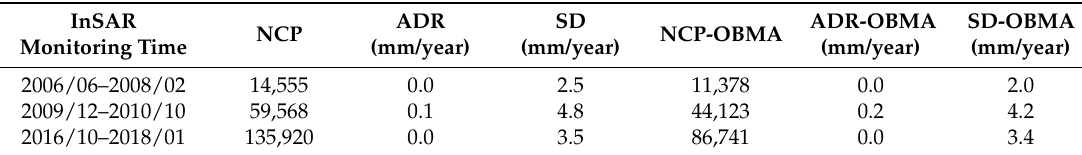
Table 2. Statistical information of deformation in the study